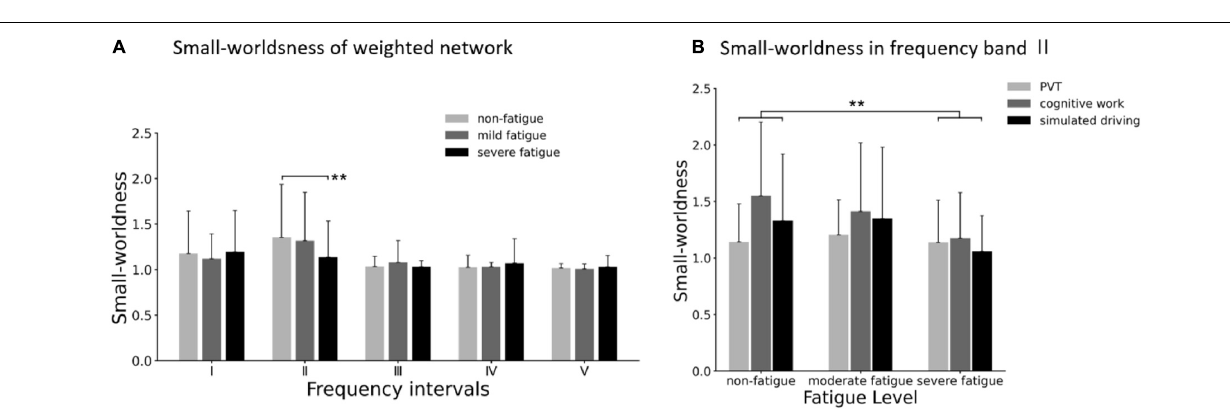
FIGURE 11 | (A) Comparison of small worldness in weighted network of three fatigue levels in five frequency bands. (B) Results of post-hoc analyses of small worldness in weighted network in frequency band II (0.021–0.052 Hz). Vertical bars are standard errors scores. ** p <